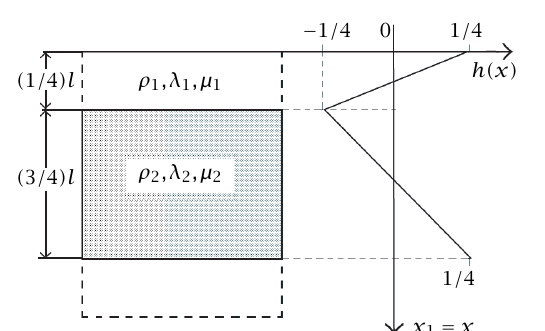
Figure 1.2 . A microperiodic shape function h = h(x) over the interval 0 ≤ x ≤ l